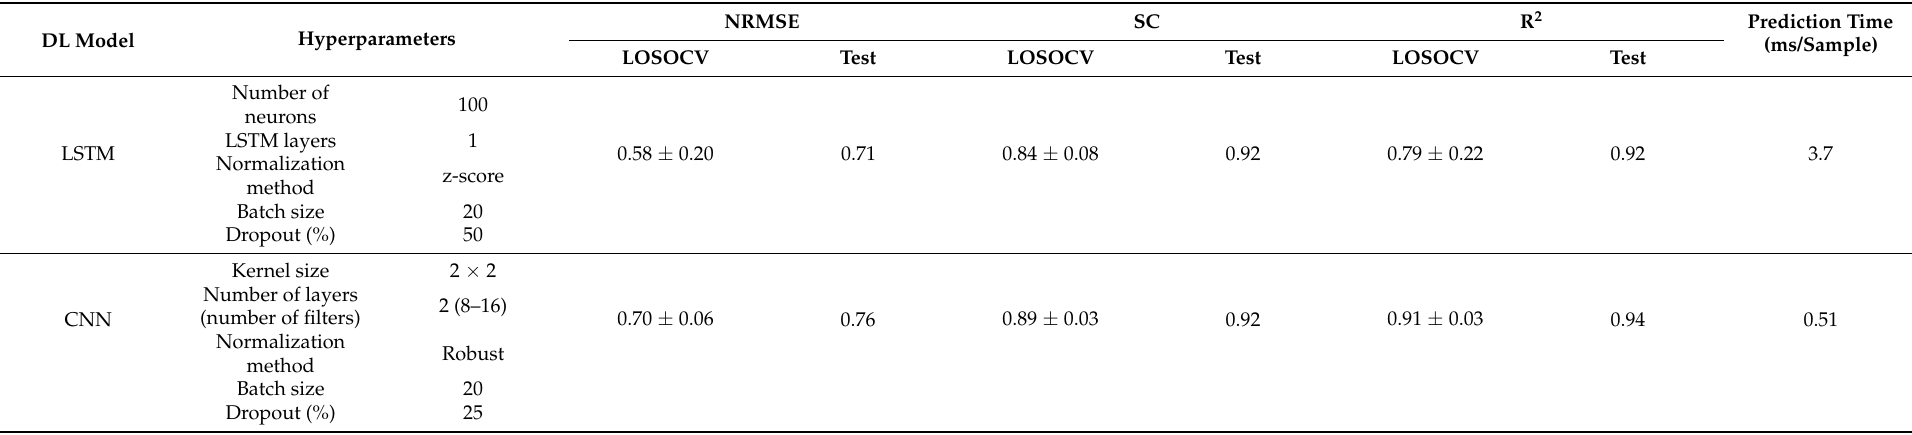
Table 2. NRMSE, SC, R 2 , and computational time results for both DL models without using EMG